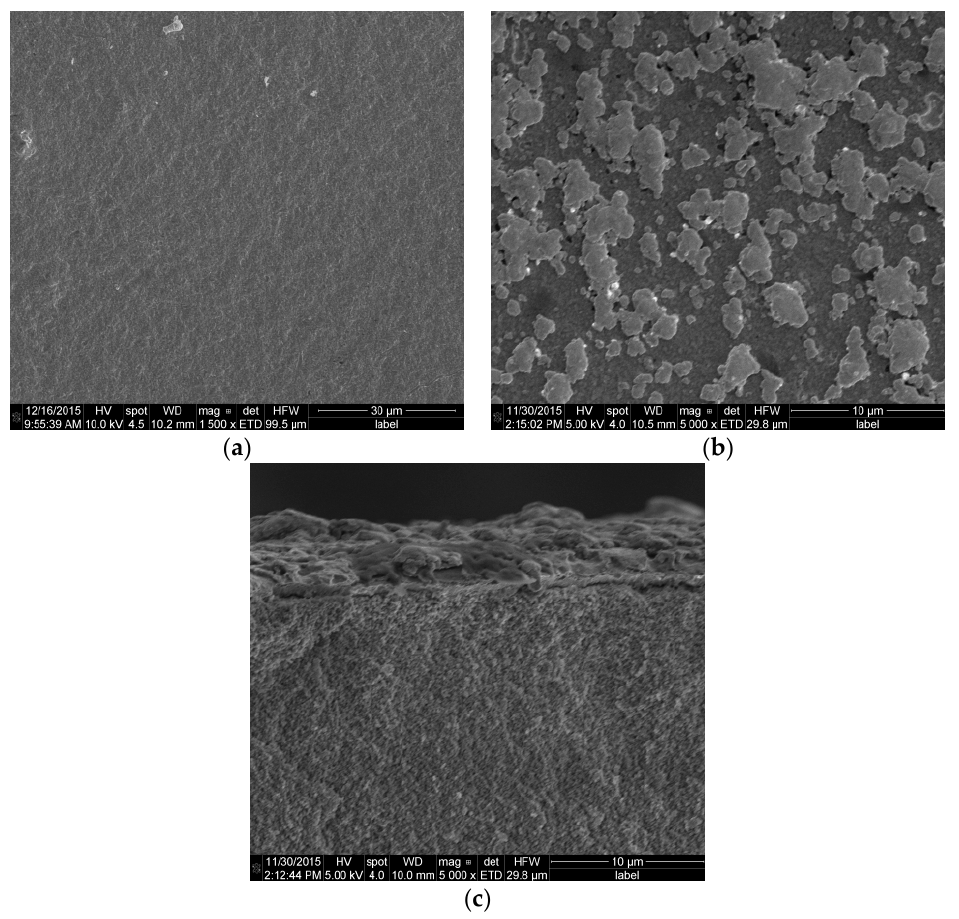
Figure 10. SEM images: ( a ) fresh membrane surface; ( b ) membrane surface after 900 h of continuous operation under bubbling fluidization conditions and WGS; and ( c ) membrane cross section.